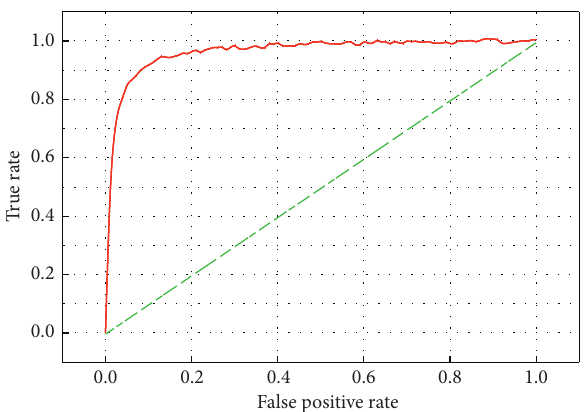
Figure 5: ROC of a decision tree on 30% test set.